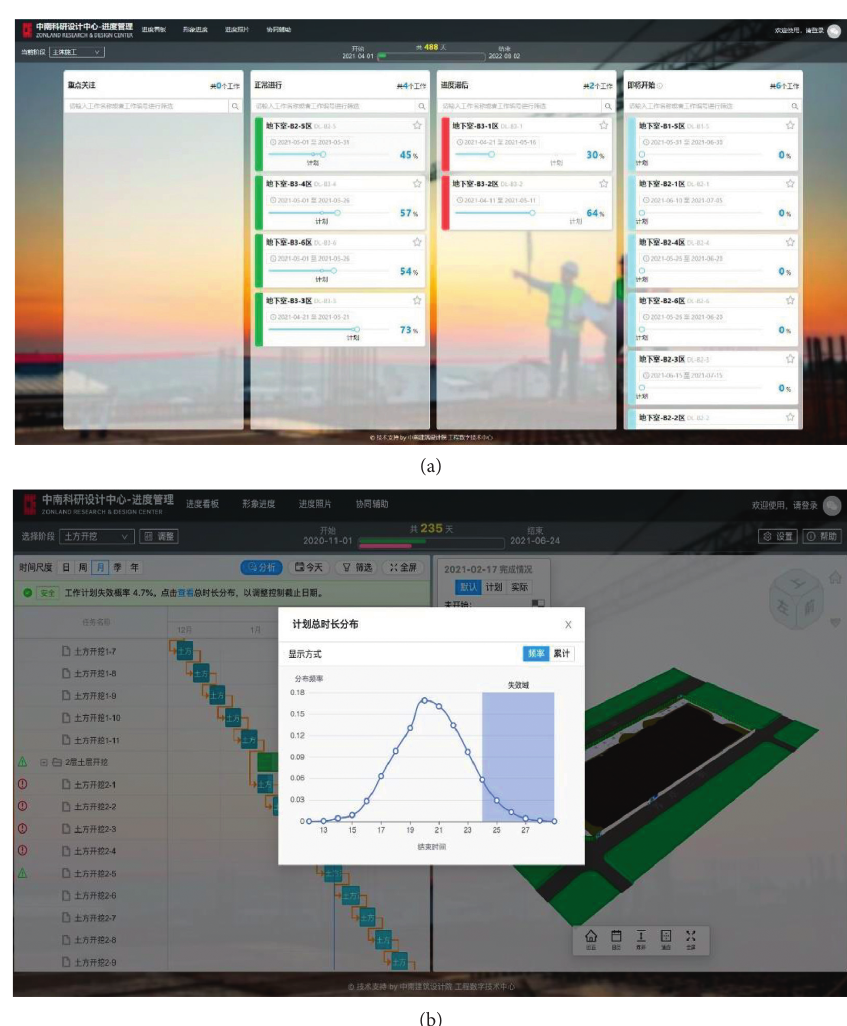
Figure 6: Screenshot of our simulation system. (a) Task Kanban: this page is used to display and submit current working progress; project manager could drag the slider to update the progress of a task. (b) Schedule evaluation: this page is used to visualize current working progress and evaluate the reliability of schedule. Project manager could find the dangerous tasks marked by a red exclamation in a circle from